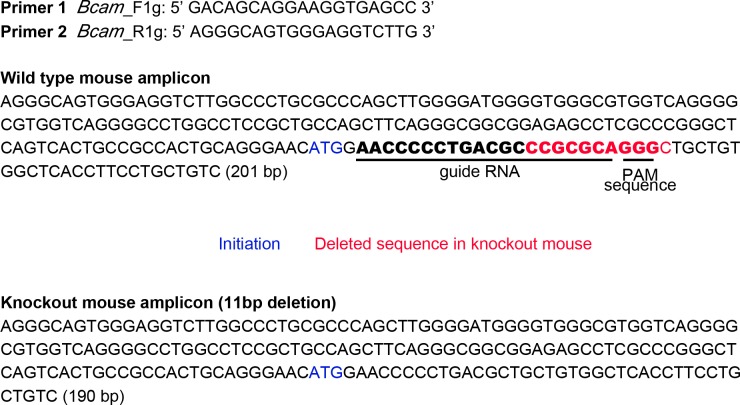
Generation of Bcam KO mouse by using the CRISPR/Cas9 method.Schematic illustration of the mouse Lu/Bcam gene structure and sequences around the targeted allele. Blue and red letters stand for an initiation ATG codon and the deleted sequence (11 bp) in KO mouse, respectively. The sequence for gRNA and protospacer-adjacent motif (PAM) are underlined. Genomic PCR of WT and Bcam KO mice using a set of Primer 1 and Primer 2 yields amplicon corresponding to 201 and 190 bp, respectively. Information on Source data.